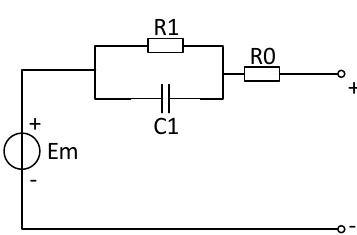
Figure 4. First-order resistor-capacitor (RC) equivalent circuit model.